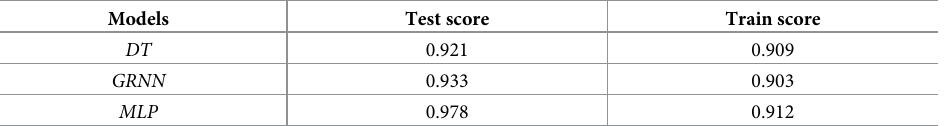
Table 4. Final values of R 2 -scores for three